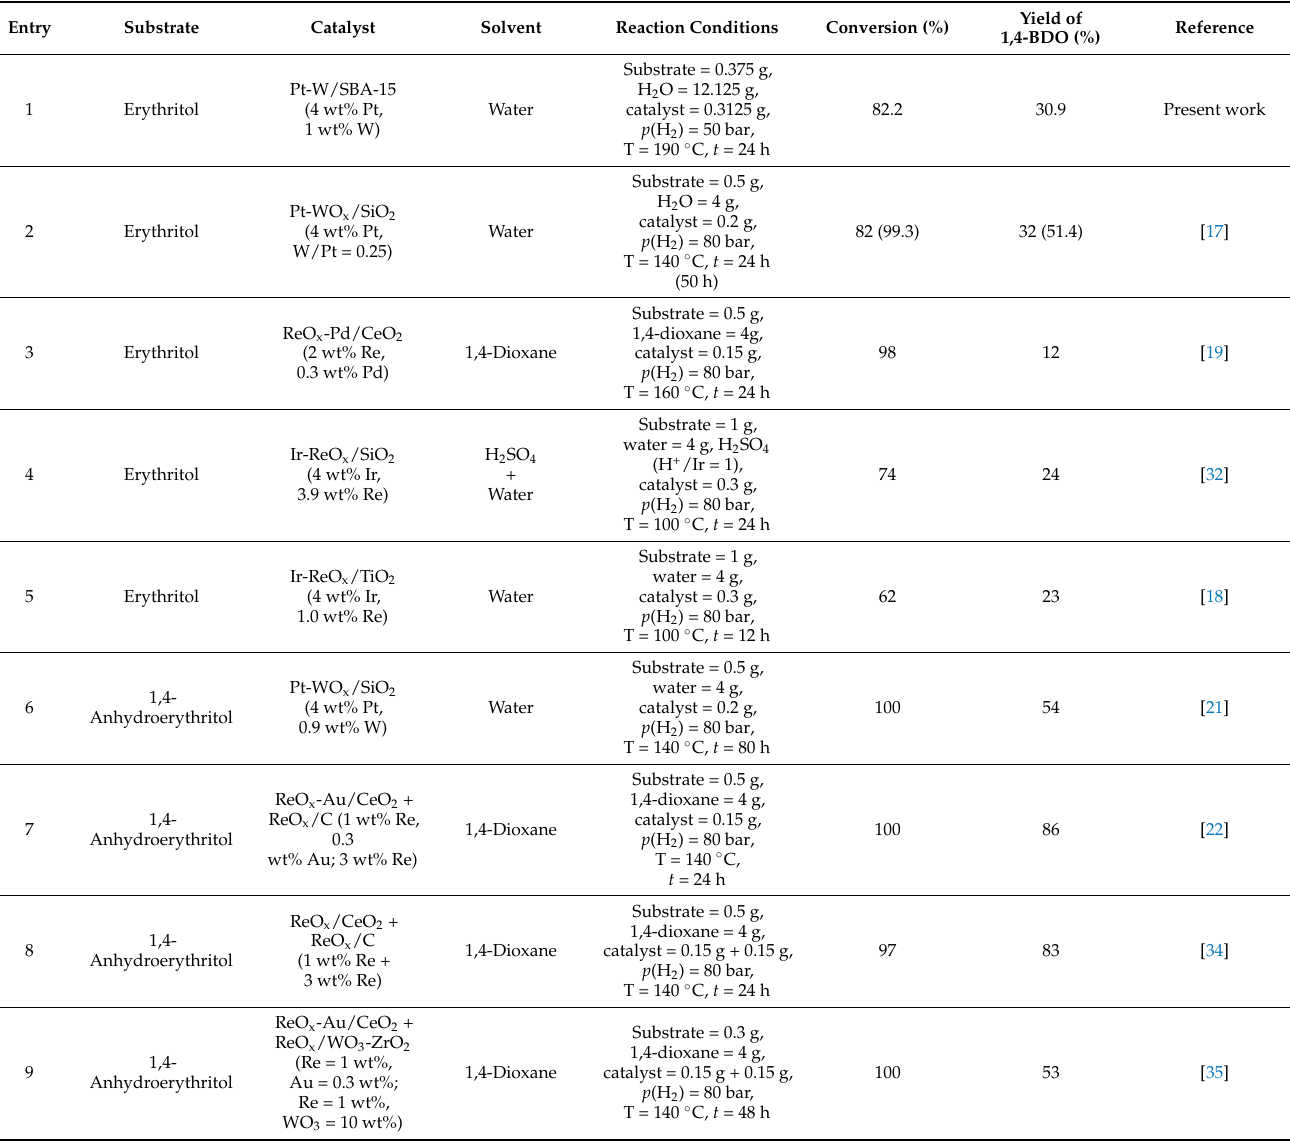
Table 3. Comparative catalytic activity data bifunctional catalyst for